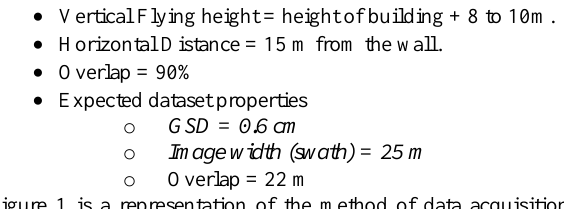
Figure 1 is a representation of the method of data acquisition that provided the desired results.